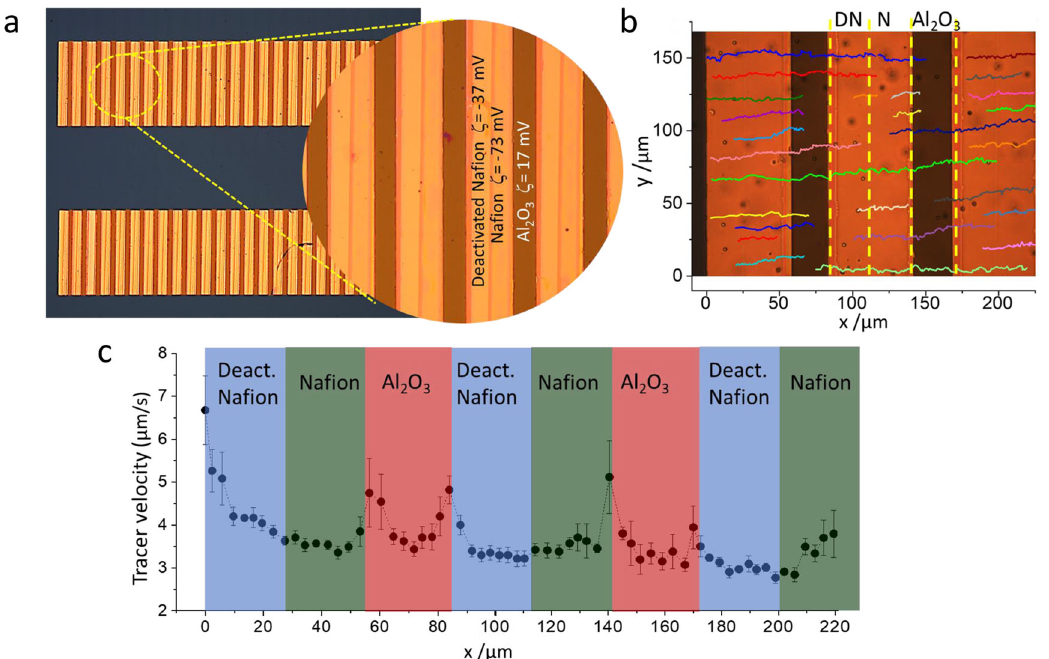
Fig. 3 Unidirectional pumping with deactivated Na fi on/Na fi on/Al 2 O 3 nanostructures. a Patterned array of strips made from the repetitive unit composed of deactivated Na fi on (25 μ m, ζ = − 37 ± 3 mV) /Na fi on (25 μ m, ζ = − 73 ± 3 mV) /Al 2 O 3 (30 μ m, ζ = 17 ± 2 mV). b Tracer trajectories along the patterned surface proving directional motion (DN and N refer to deactivated Na fi on and Na fi on, respectively). c Average tangential velocity of polystyrene tracers along the patterned structure. Blue, green and red shaded areas represent deactivated Na fi on, Na fi on and Al 2 O 3 strips, respectively. Error bars in the fi gure represent the standard deviation. Source data of b , c are provided as a Source Data fi